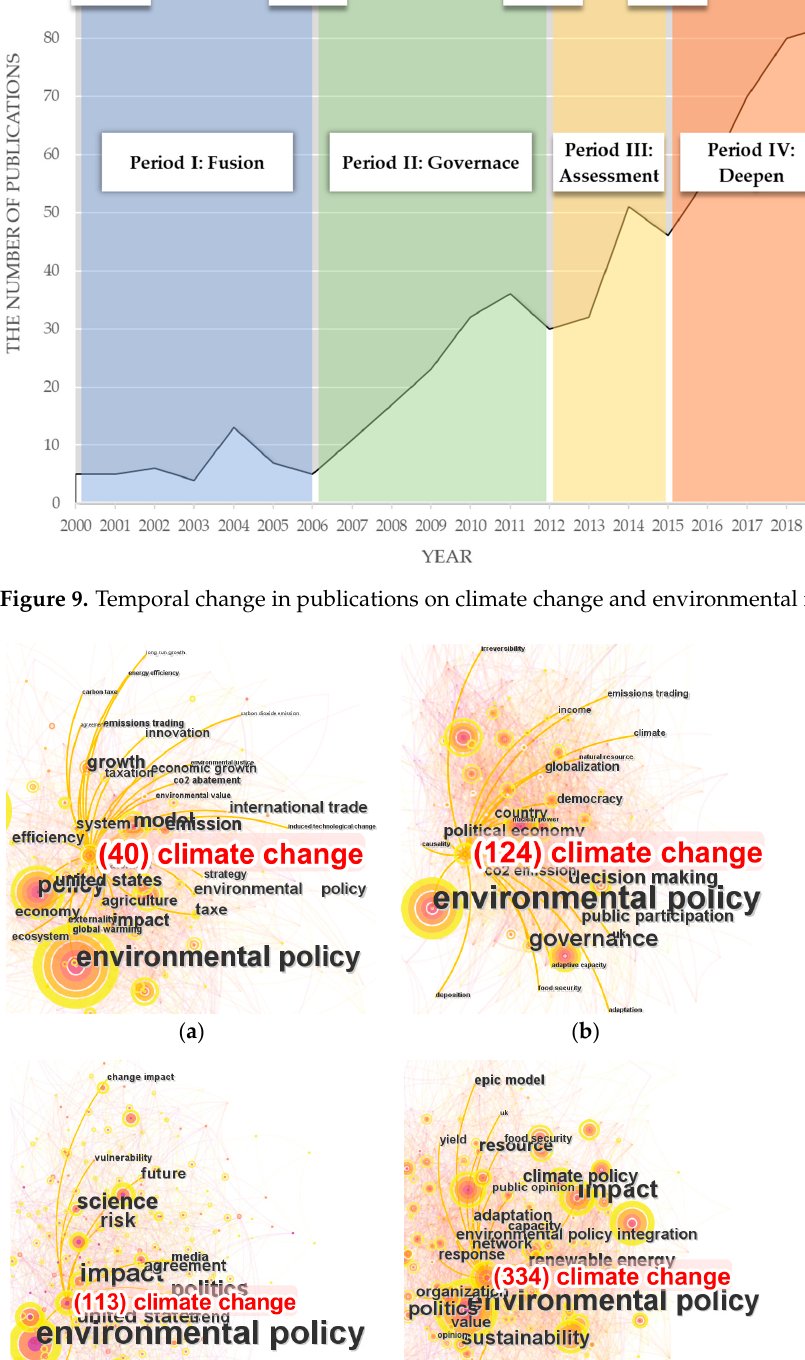
Figure 9. Temporal change in publications on climate change and environmental regulation.